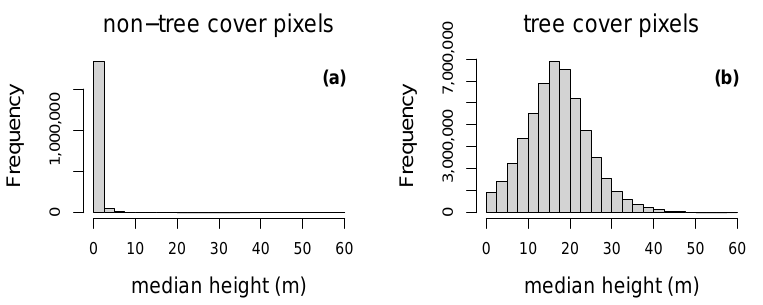
Figure 3. Distribution of median height in the planet pixels that intersects (with full overlap) with 141 EBA LiDAR datasets randomly distributed over Mato Grosso, for planet pixels classified by U-net as non-tree cover ( a ) and tree cover ( b